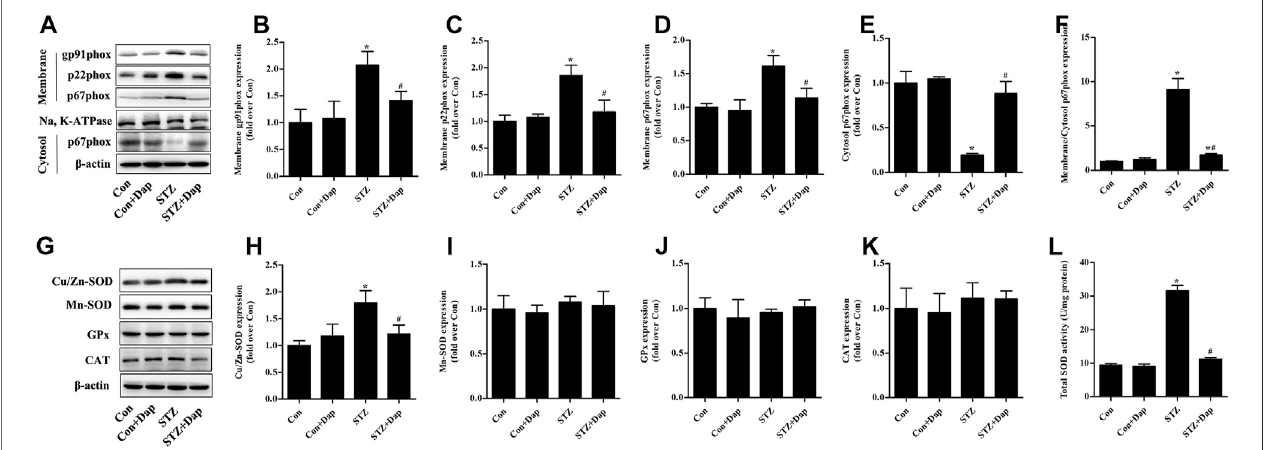
FIGURE 3 | Effects of DAP on myocardial NADPH oxidases and antioxidant enzymes in diabetic rats (A) Panel shows representative bands of NADPH oxidases. Histograms represent densitometry analysis of the membrane gp91phox (B) , p22phox (C) , and p67phox (D) protein, the cytosol p67phox (E) protein, and the ratio of p67phox protein expression in membrane to cytosol (F) (G) Panel shows representative bands of antioxidant enzymes. Histograms represent densitometry analysis of the copper, zinc superoxide dismutase (Cu/Zn-SOD, H ), manganese superoxide dismutase (Mn-SOD, I ), glutathione peroxidase (GPx, J ), catalase (CAT, K ) (L) Myocardial levels of total SOD activity were measured. n (cid:1) 3 – 4. Data are expressed as the mean ± SD. * p < 0.05 vs. Con; # p < 0.05 vs.